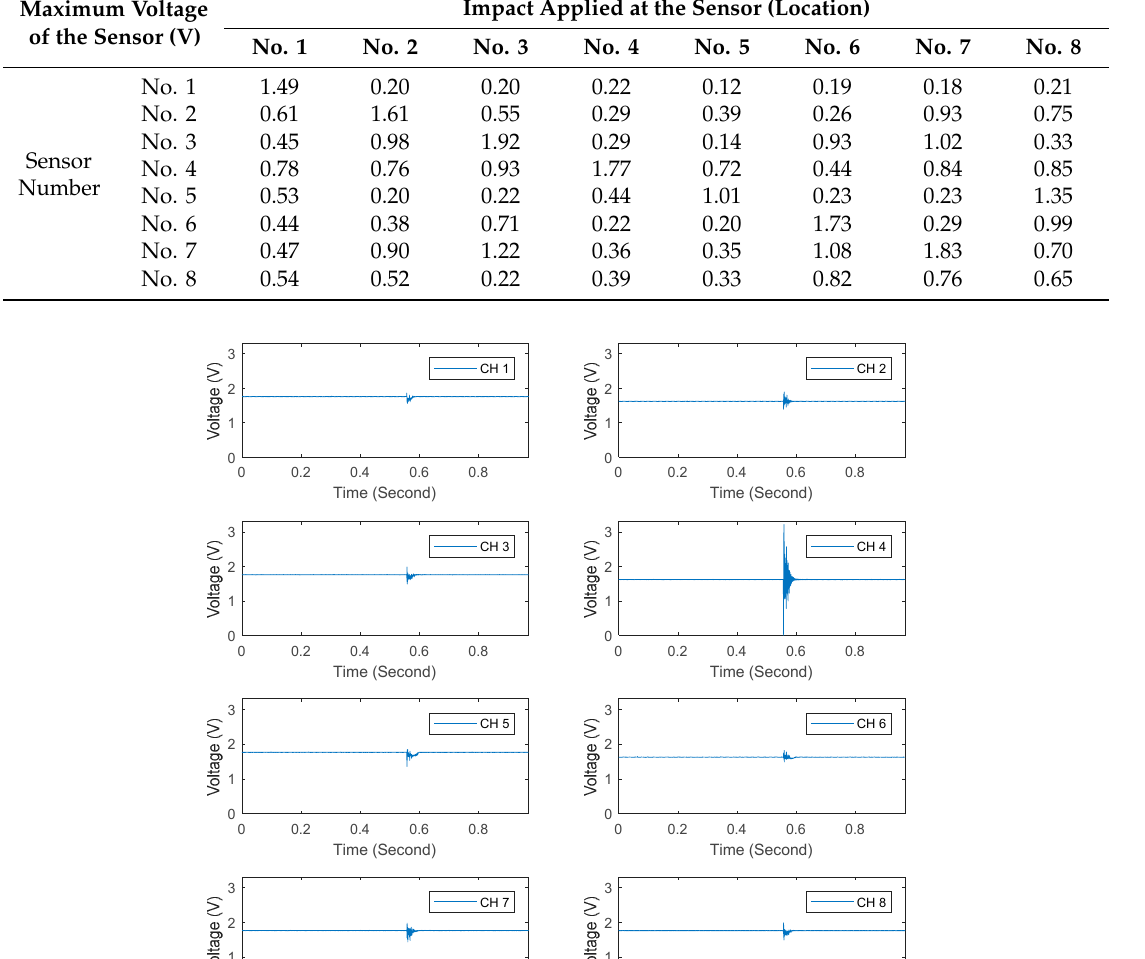
Table 4. Maximum voltage of each sensor when strikes are applied to di ff erent sensors.